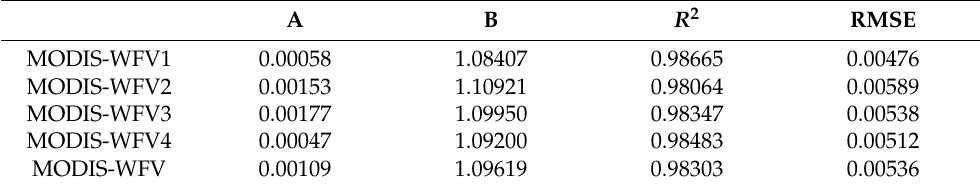
Table 4. Statistical information of blue band LSR between MODIS and different WFV cameras of